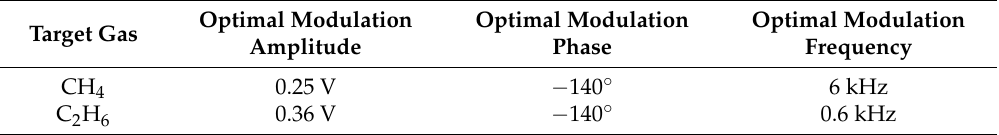
Table 1. Optimal modulation amplitude, phase, and frequency of CH 4 and C 2 H 6 .